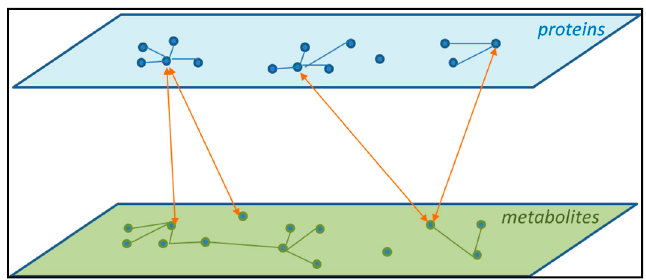
Figure 2. Interactions among members within and between two biological levels, protein and metabolites.